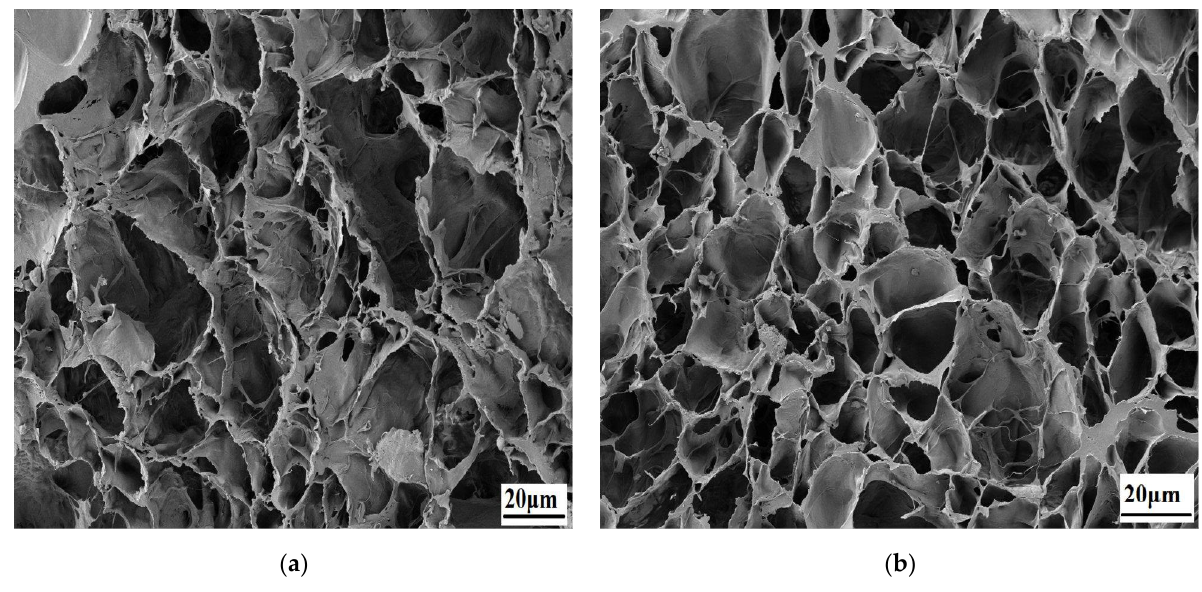
Figure 2 . Scanning electron micrographs of ( a ) PVA/PVP and ( b ) PVA/PVP/2HNr hydrogel. Table 1 . PVA/PVP/HNr composite hydrogel physical properties .